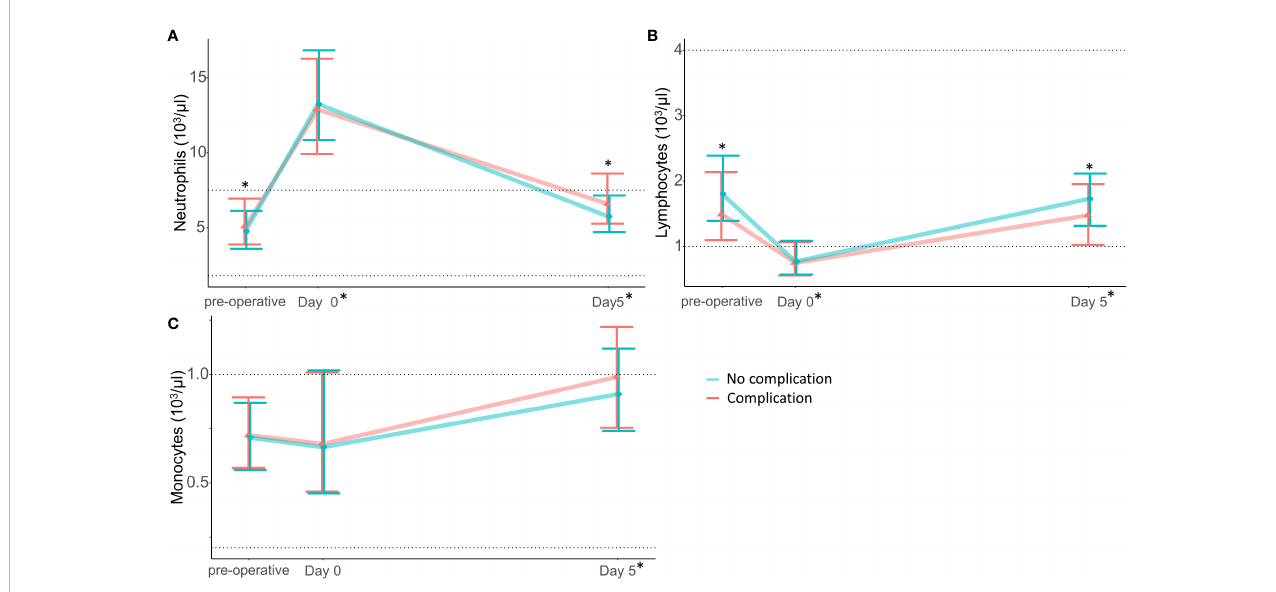
FIGURE 3 White blood cell count are modi fi ed by cardiac surgery and are associated with post-operative complications. (A) Neutrophils, (B) Lymphocytes, (C) Monocytes Dotted line represent normal range for each parameter * above the plot refers between groups signi fi cant difference (non-parametric test, p- value were corrected using Bonferroni ’ s method). * on the x-axis report signi fi cant differences from baseline (intragroup comparison with p < 0.05). Red represent patient that developed the composite complication criteria and blue patient who did